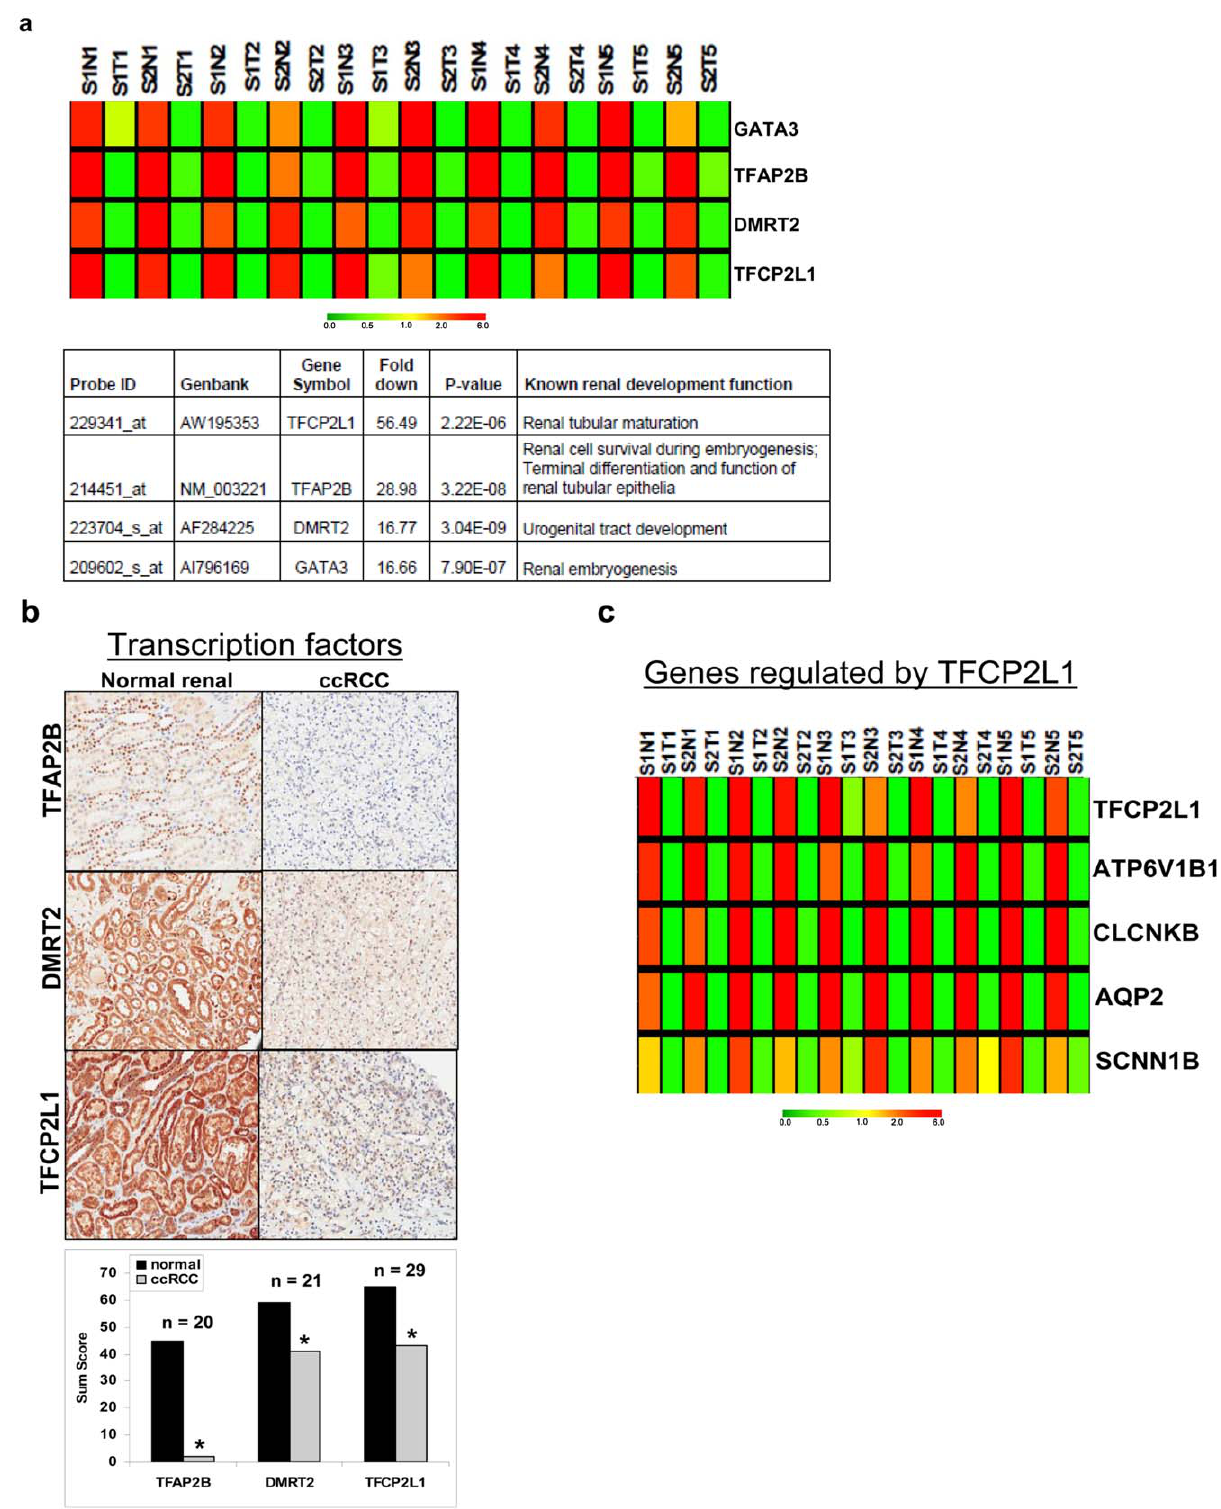
Figure 3. Loss of developmental transcription factors in clear cell renal cell carcinoma. a. A microarray heatmap showing significant downregulation of four developmental transcriptional factors in ccRCC and a table showing fold changes of DTFs and their known renal developmental function. b. IHC validation of decreased expression of TFAP2B, DMRT2, and TFCP2L1. Sum scores are shown with n , as indicated. *p , 0.01 when comparing ccRCC to normal match. c. Microarray heatmap showing downregulation of TFCP2L1 and its regulated genes in ccRCC. S– Stage, N–normal, T–tumor. Upregulation of genes is indicated in red, downregulation is indicated in green, and similar expression is indicated in yellow, as generated by Genetree.